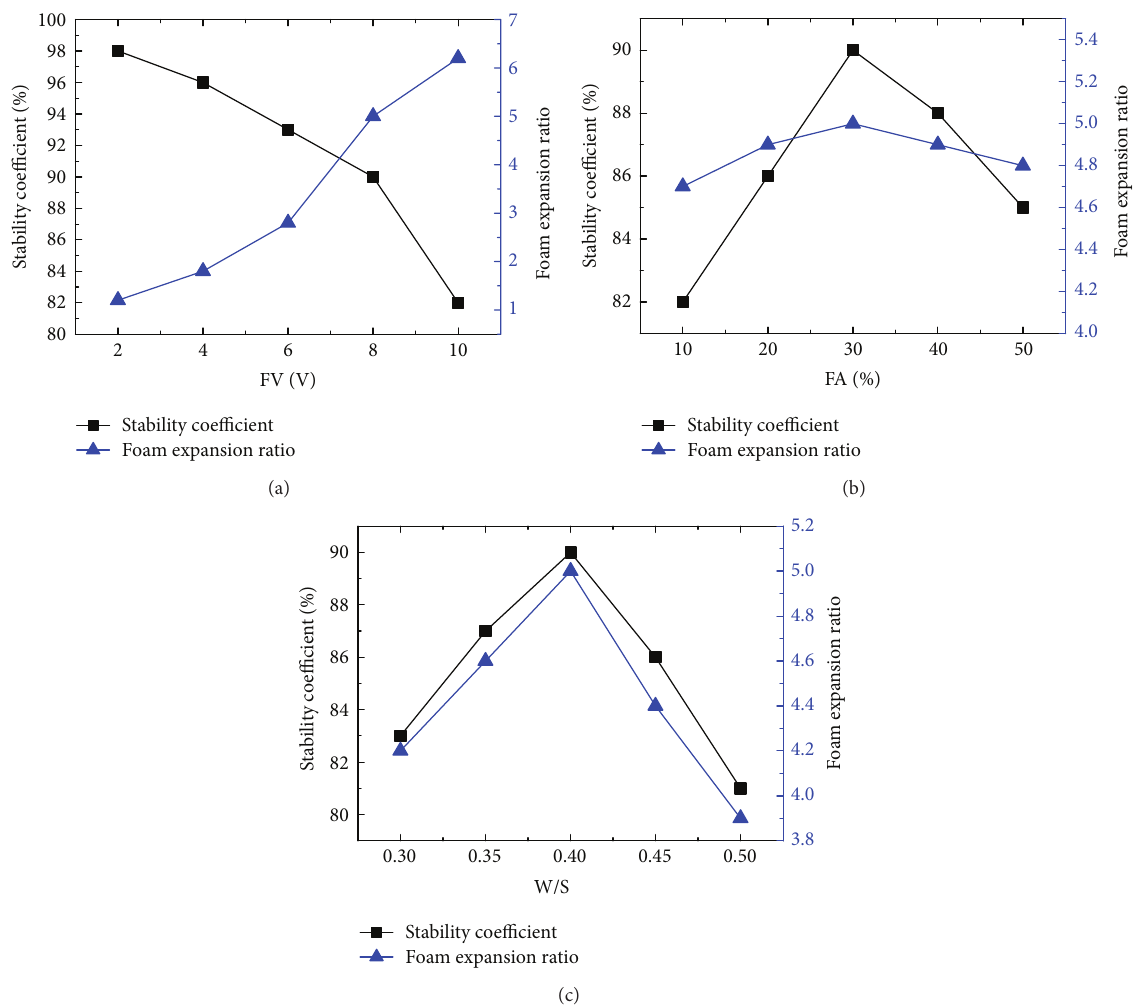
Figure 7: The change curves of stability coefficient and foam expansion ratio with different factors. (a) Independent variable is FV and constants are 30 wt.% of FA and W/S of 0.4; (b) Independent variable is FA and constants are 8V of FV and W/S of 0.4; (c) independent variable is W/S and constants are 8V of FV and 30 wt.% of FA.